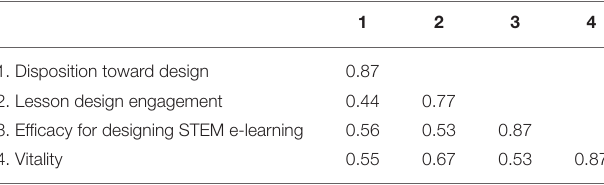
TABLE 2 | Discriminant validity test results of the measurement